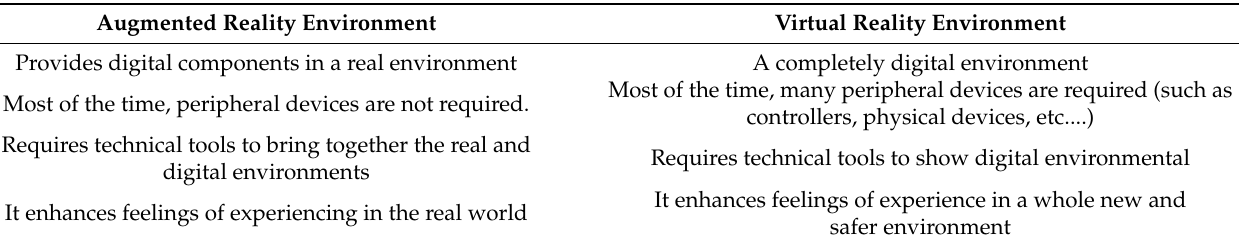
Table 4. The difference between augmented reality and virtual reality environment.